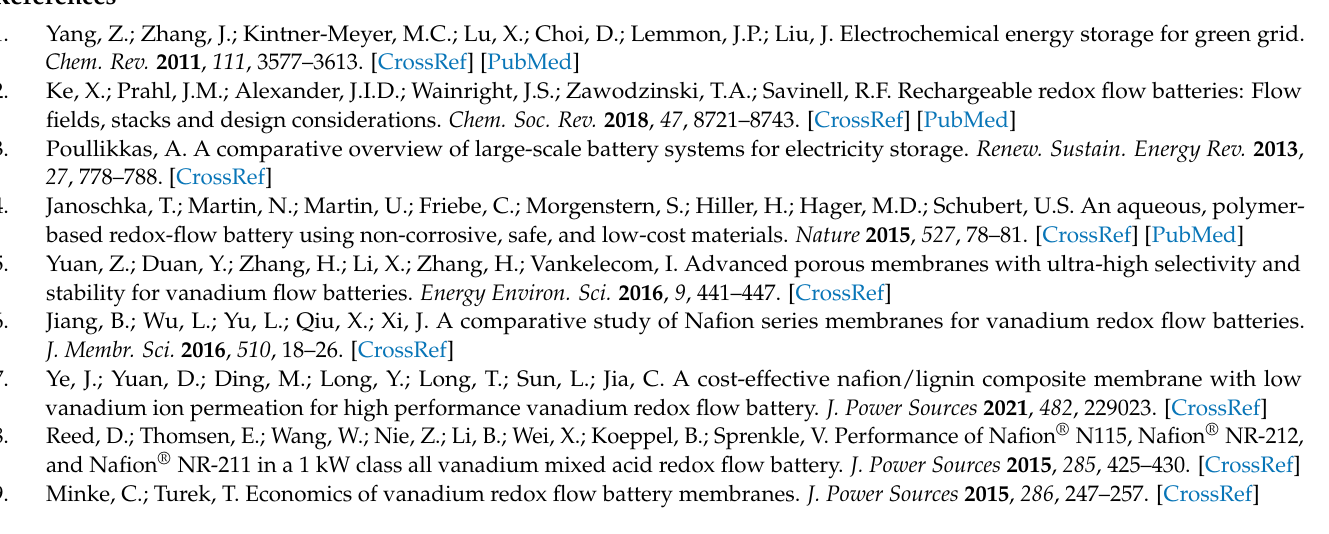
Table S1: Semi-quantitative content of elements of PE and pretreated